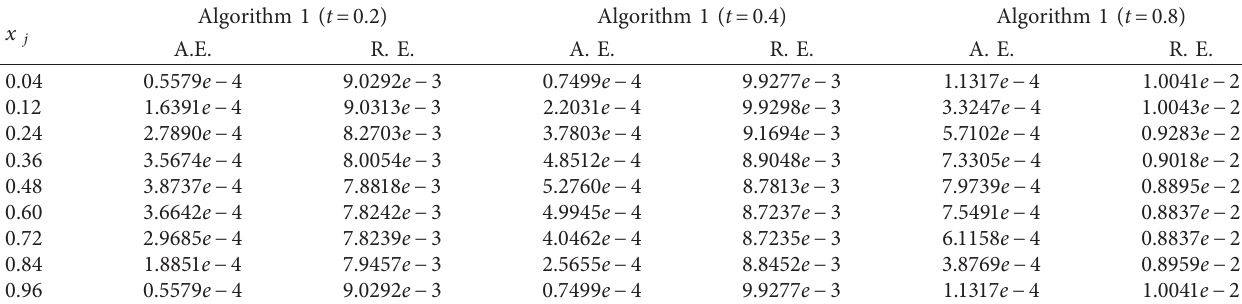
Table 3: The absolute errors and relative errors of numerical solutions to Example 1 for h � 1/25 (i.e., K � 4).